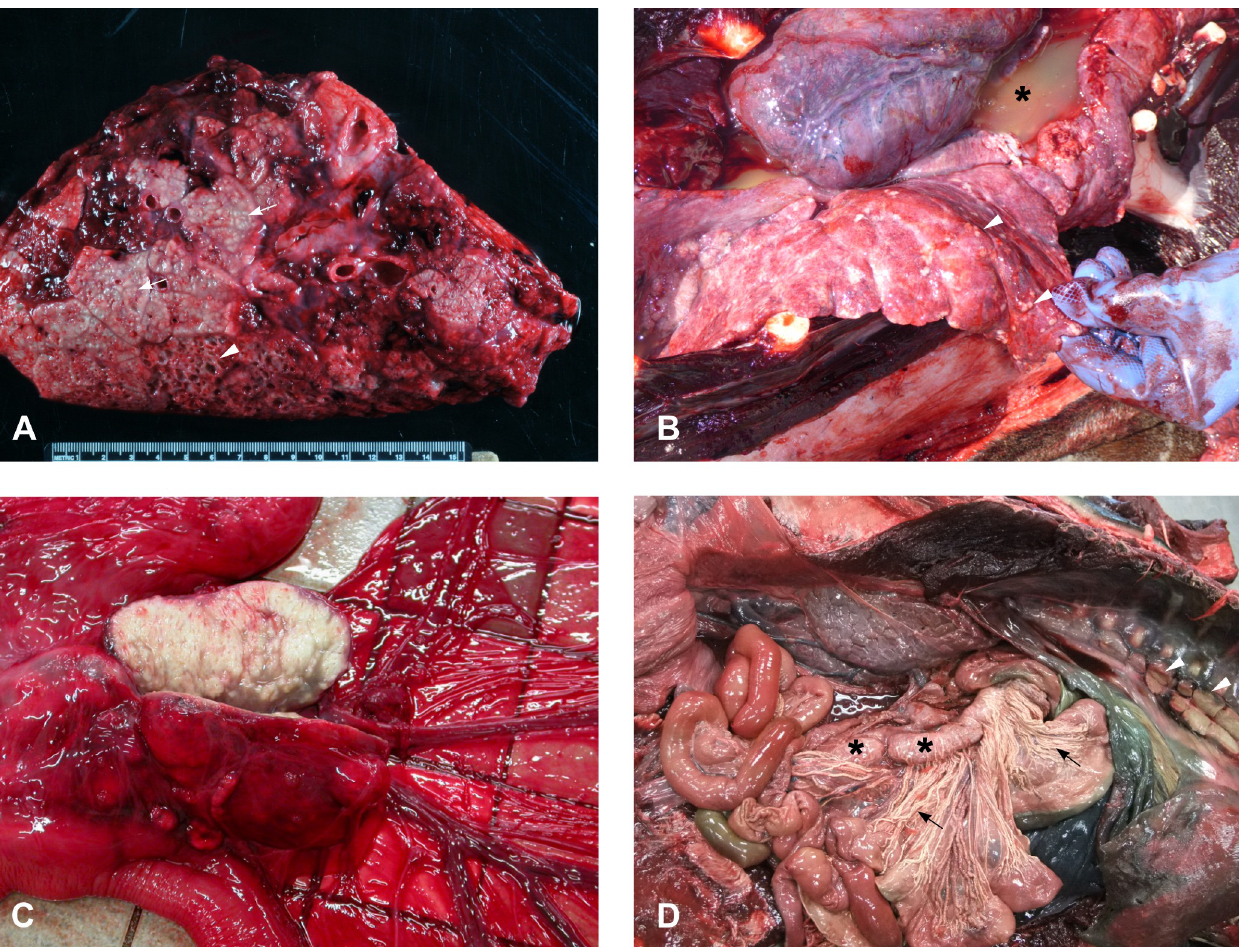
Fig 1. Gross pathology of M . pinnipedii infection. A. Cut surface of lung from a severely affected New Zealand sea lion. There are areas of lung consolidation containing multifocal to coalescing caseating granulomas (arrows). In some areas these have central areas of liquefaction and tissue loss (arrowhead). B. Miliary lesions: there are numerous small (2-4mm diameter) granulomatous lesions (arrowheads) scattered throughout the lung fields of this New Zealand sea lion, along with watery turbid fluid within the thoracic cavity (pleural effusion; asterisk). C . Cut surface of an enlarged, pale, firm, nodular mesenteric lymph node from a New Zealand sea lion with tuberculosis. D. Tuberculosis in a Hector’s dolphin. The mesenteric (asterisk) and intra-thoracic (arrowheads) lymph nodes are enlarged and pale and the mesenteric lymphatics are pale and thickened (arrows).